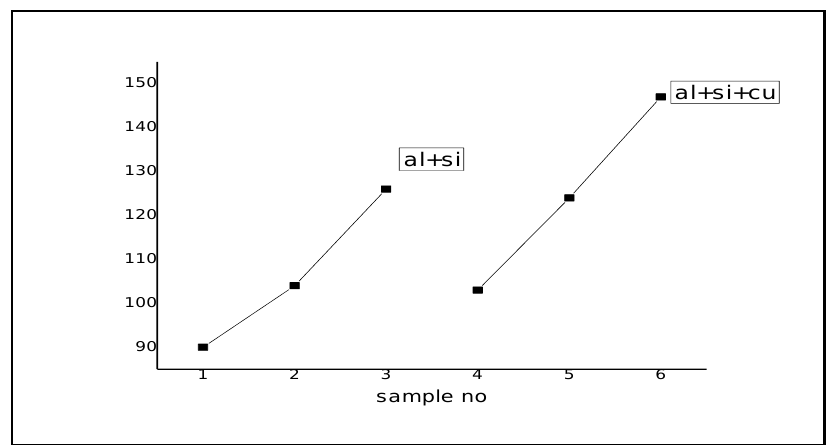
Figure 6: Curves are showing variation of Tensile Strength with sample no (Al19.5wt%Si, Al21wt%Si, Al 22.5wt% Si, Al18wt %Si+1.5wt% Cu, Al19.5wt%Si +1.5wt%Cu, Al21wt%Si +1.5wt% Cu). Table 2: Tensile Strength [Al-Si, Al-Si-Cu] of